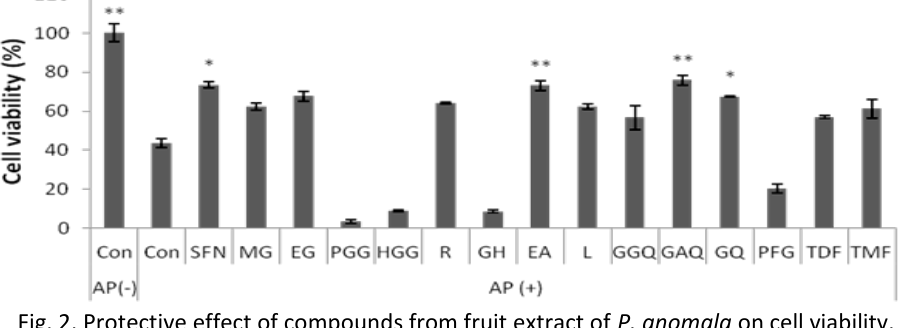
Fig. 2. Protective effect of compounds from fruit extract of P. anomala on cell viability. Each value represents the mean ±S.D. of three independent experiments with triplicate. Student’s t - test compared with AP treated group: * p < 0.005, ** p < 0.001